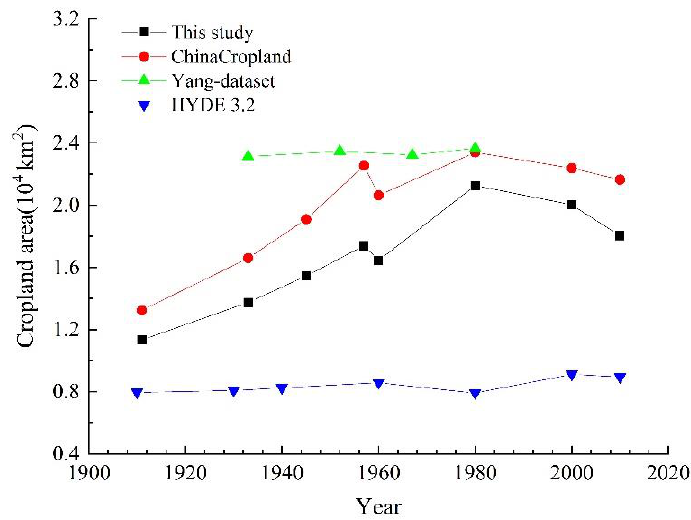
Figure 10. Comparison with cropland data from public datasets.